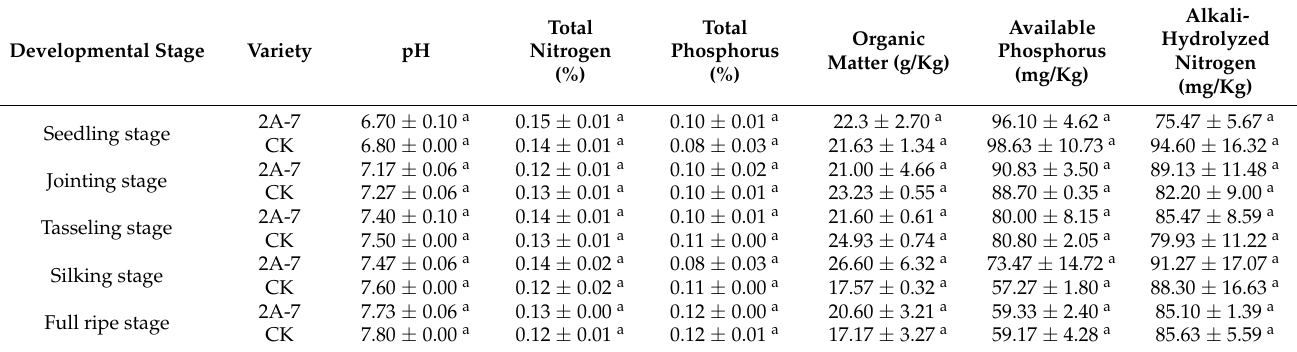
Table 1. Changes in the physical and chemical properties of the rhizosphere soils of transgenic maize 2A-7 and non-transgenic maize at different developmental